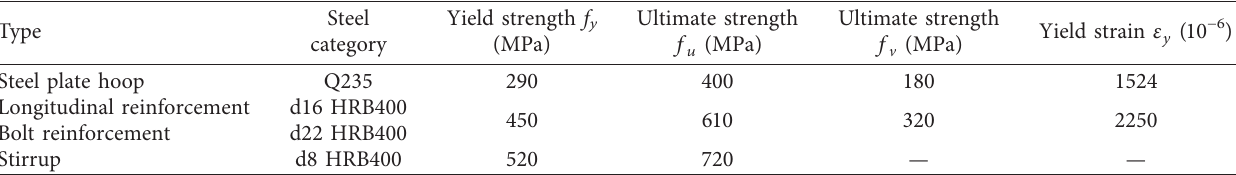
Table 2: Mechanical properties of